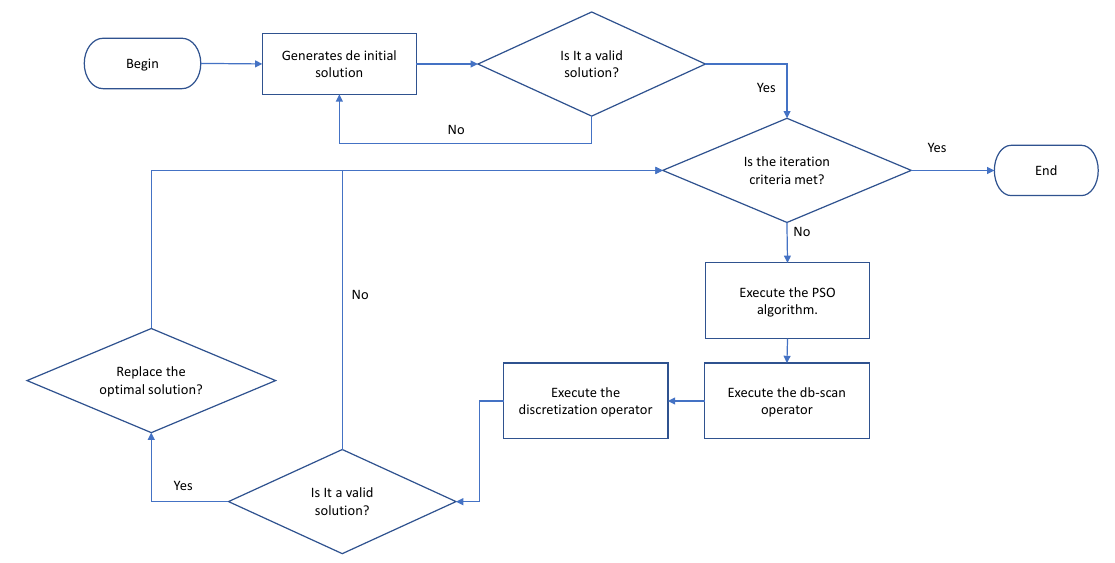
Figure 6. The discrete db-scan algorithm flow